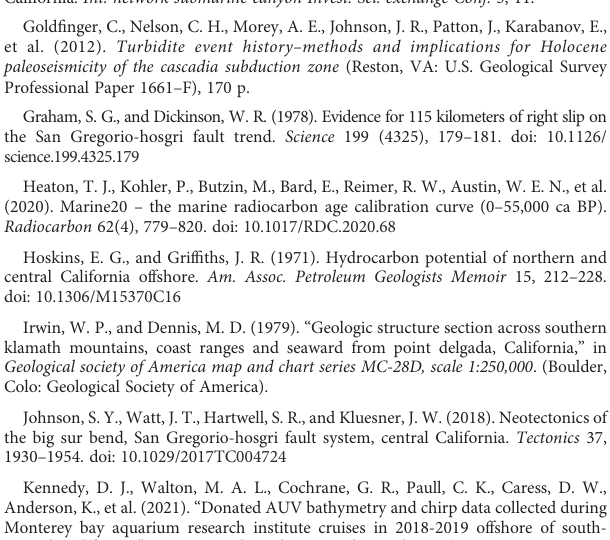
SUPPLEMENTARY FIGURE 1 (A) Annotated perspective view looking northwest at submarine slump scarp and deposit. Vertical exaggeration = x5. (B) Subsurface chirp line Z- Z ’ imaging the slip surface and folded allochthonous mass. The presence of a minor depression above the primary slip surface may be evidence of a secondary retrogressive failure surface. (C) Enhanced view of inset rectangle in B. Note the contact between the slip surface and slump, which shows potential drag